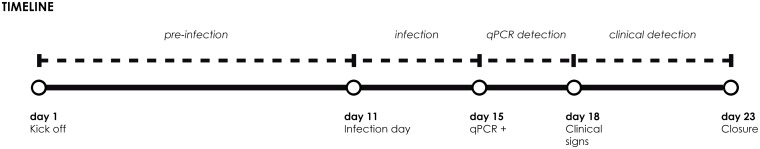
Timeline showing the four analytical phases of the experiment.The experiment began on day 1 (kick off), and animals were inoculated with ASF virus on day 11. On day 15, six of eight animals tested positive for the virus by quantitative PCR. On day 18, clinical signs of ASF became evident in five of eight animals. The experiment ended on day 23.